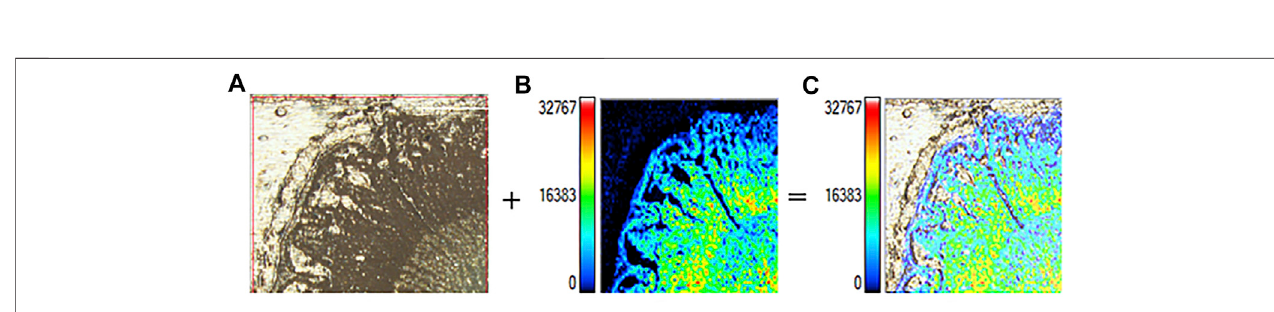
FIGURE 6 | Optical image (A) , mass spectrometry image (B) , and overlay image (C) of the dried root of Isatis indigotica .